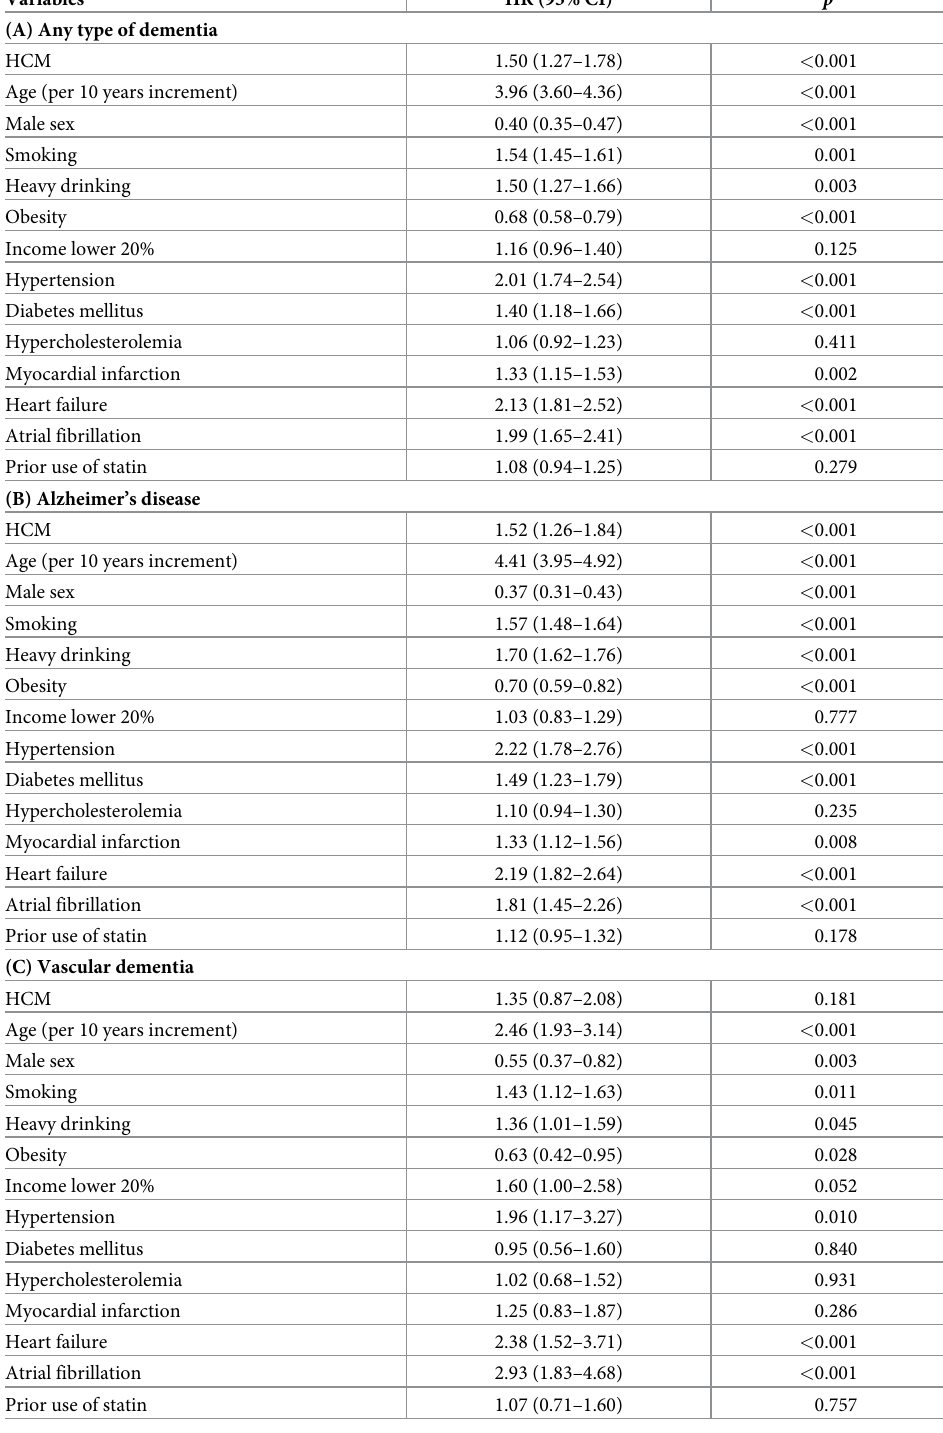
Table 3. The comparison of the impact on any type of dementia, Alzheimer’s disease, and vascular dementia by Cox regression